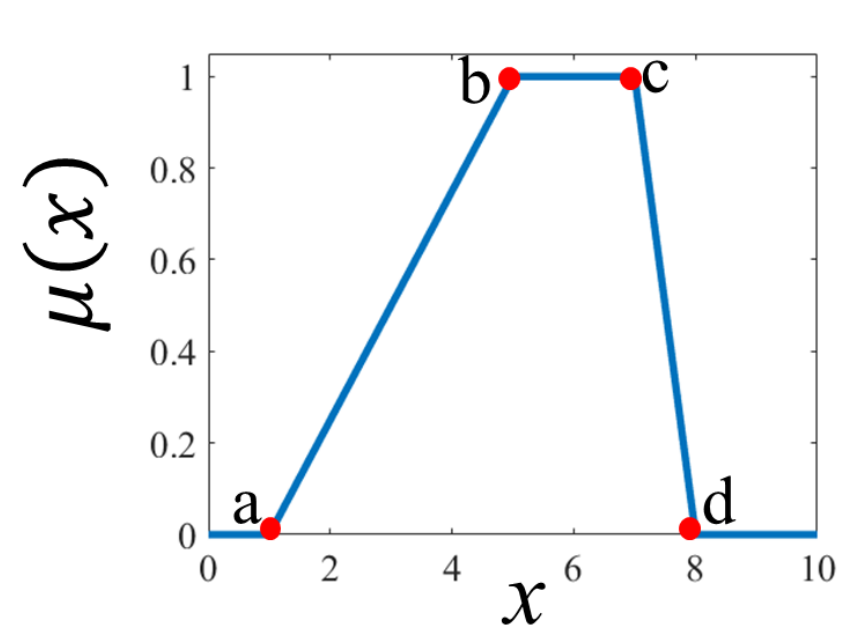
Figure 7. Points of trapezoidal membership function.